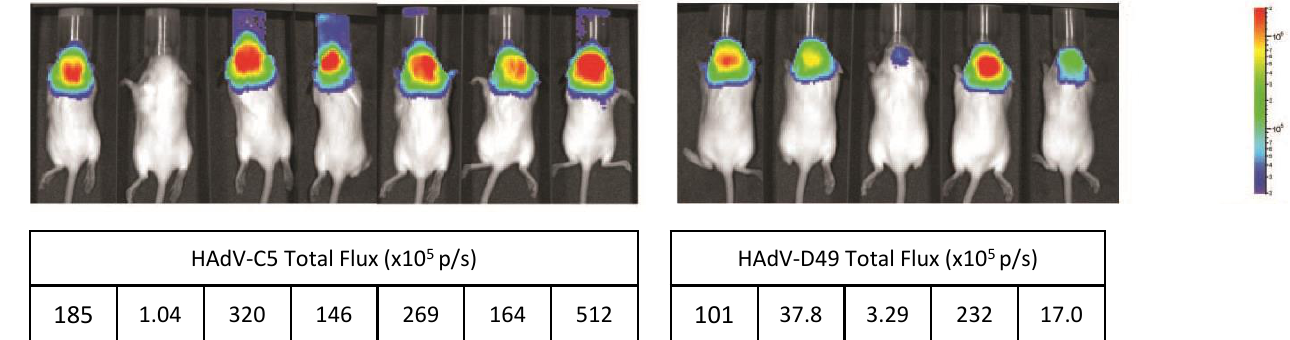
Figure 4. In vivo bioluminescence imaging of luciferase expression mediated by HAdV-C5 (Ad5) vectors compared to HAdV-D49 (Ad49) vectors after foetal intracranial injection. IVIS imaging system was performed at three months of age. Quantification of bioluminescence is shown in table (total flux ×10 5 p/s).